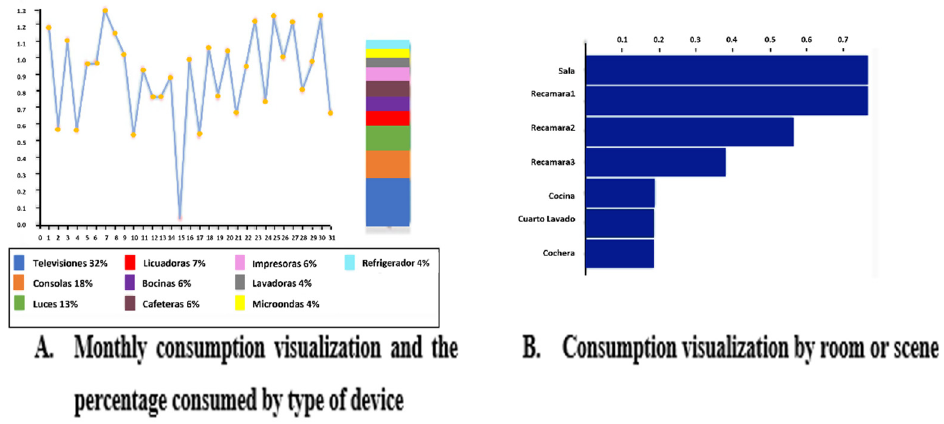
multiplying the number of days according to the month it refers to by 24.